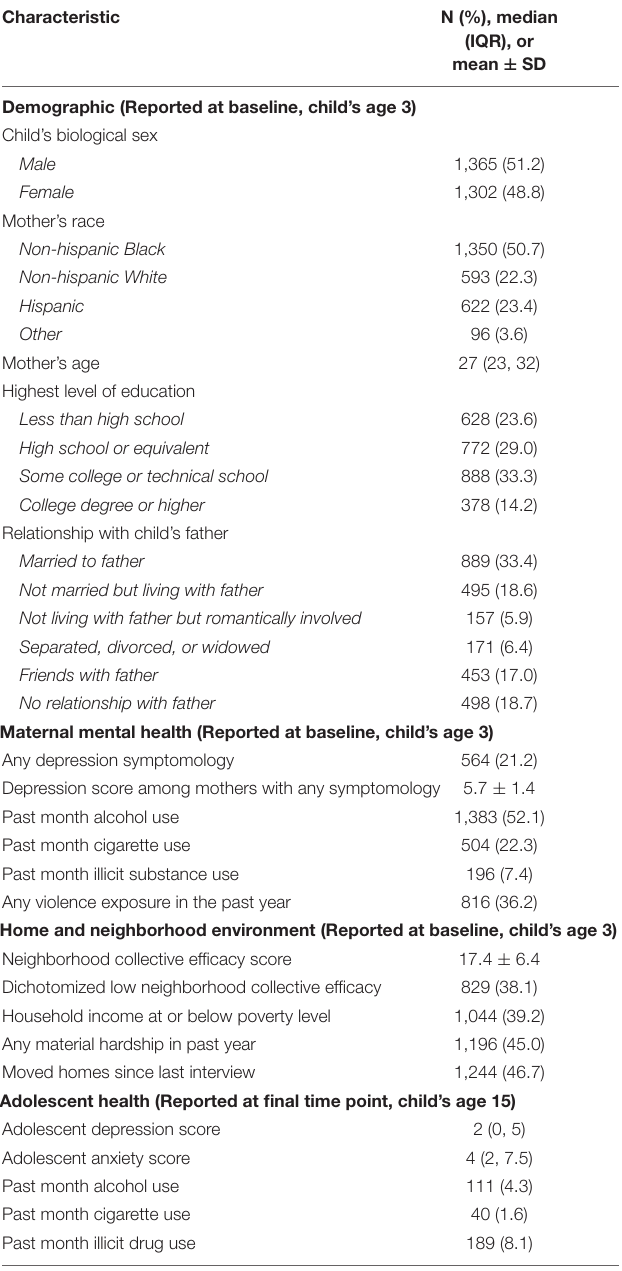
TABLE 1 | Descriptive statistics of all demographic characteristics and